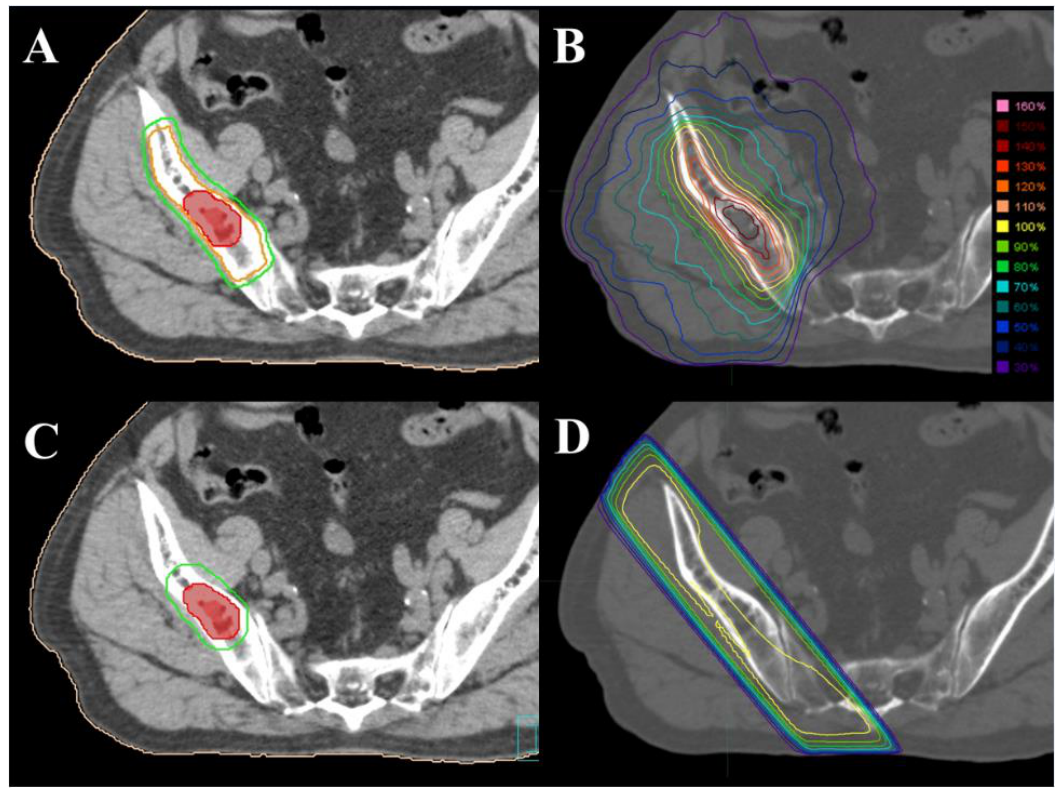
Figure 1. Axial computed tomography images with contours (red = gross tumor volume, orange = clinical target volume, and green = planning target volume) and dose distribution of stereotactic body radiotherapy ( A , B ) and conventional external beam radiotherapy ( C , D ) for coxal bone metastases.